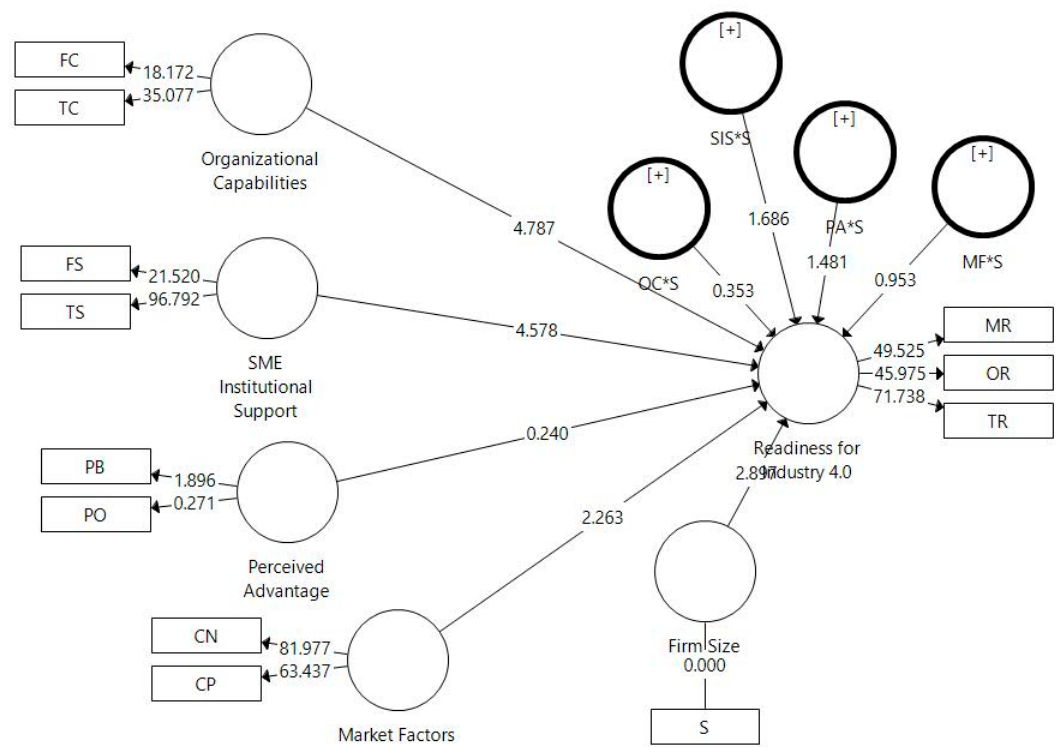
Figure 2. Bootstrapped model